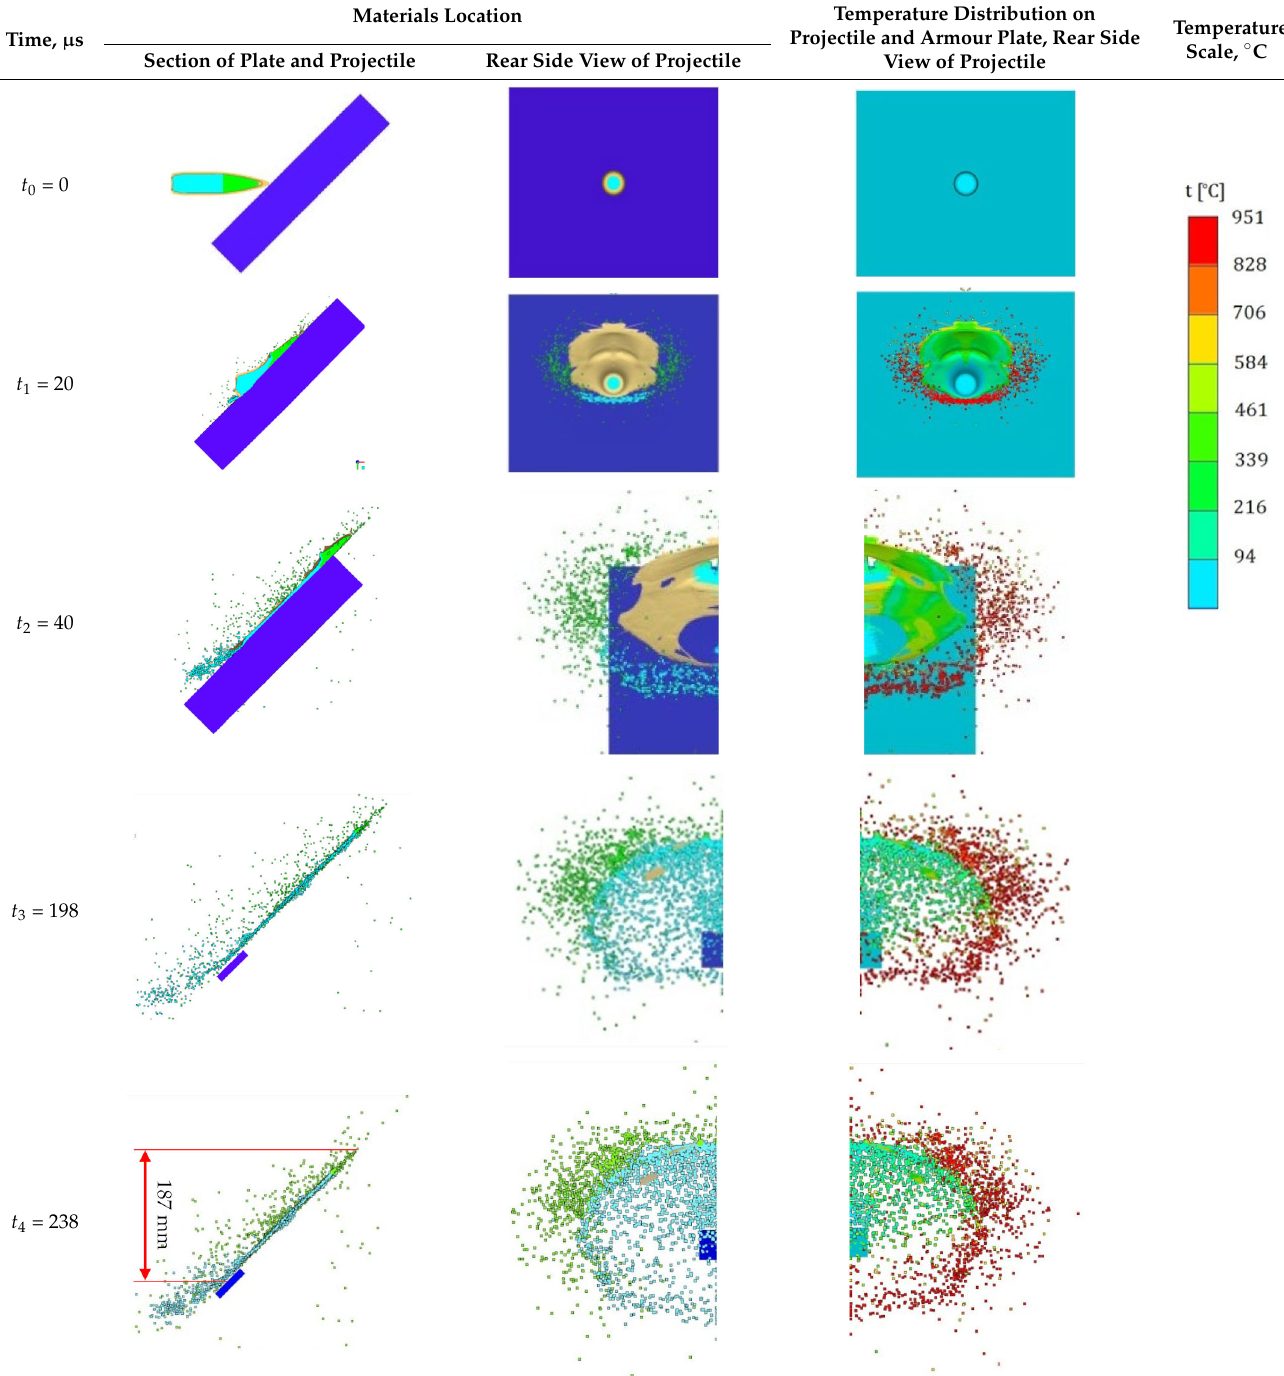
Table 3 shows the projectile hitting the plate in numerical simulation. Projectile behaviour, fragmentation and a map of the temperature distribution for the projectile, its fragments and the armour plate for times as close as possible to the time recorded with the high-speed camera were presented, so that the calculations could be compared with the experiment. The height of the debris cloud at 238 µ s for numerical approach is 187 mm, while for the experiment amounts it was 175 mm, which gives a difference equal to 12 mm (7%). Table 3. Numerical simulation of projectile impact onto armour